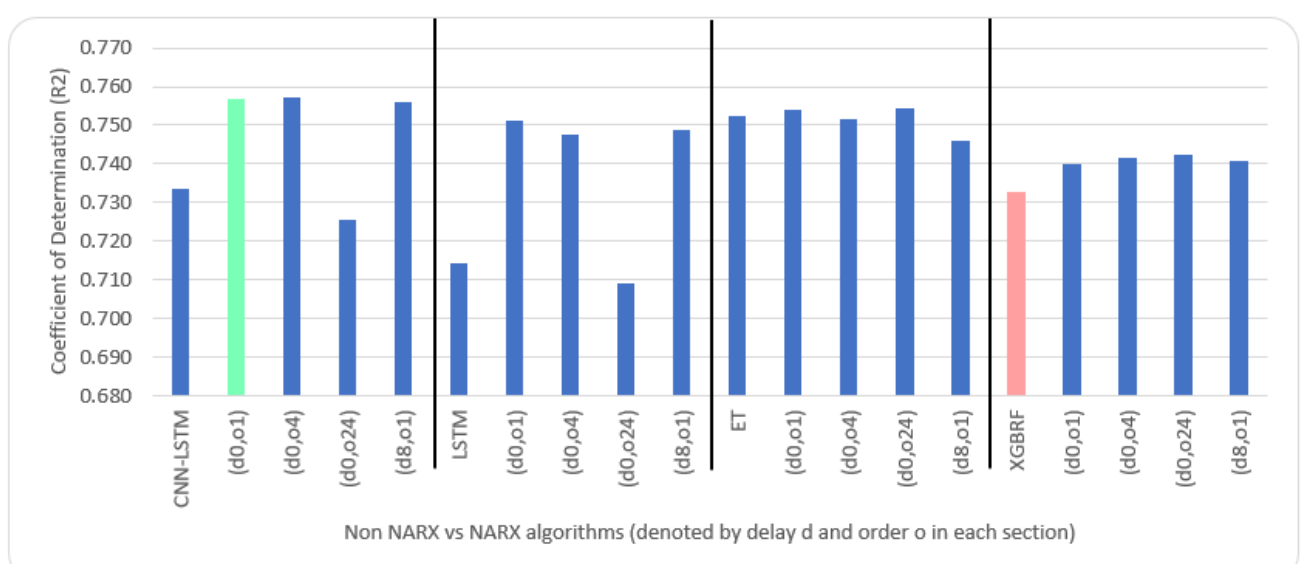
Figure 27. Evaluation results of non-NARX and NARX in terms of coefficient of determination for the Manchester dataset.